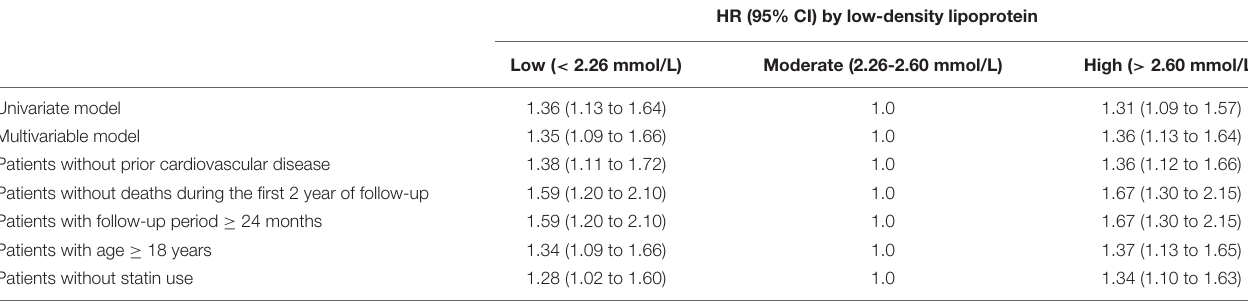
TABLE 3 | Association between low-density lipoprotein cholesterol and all-cause mortality*.